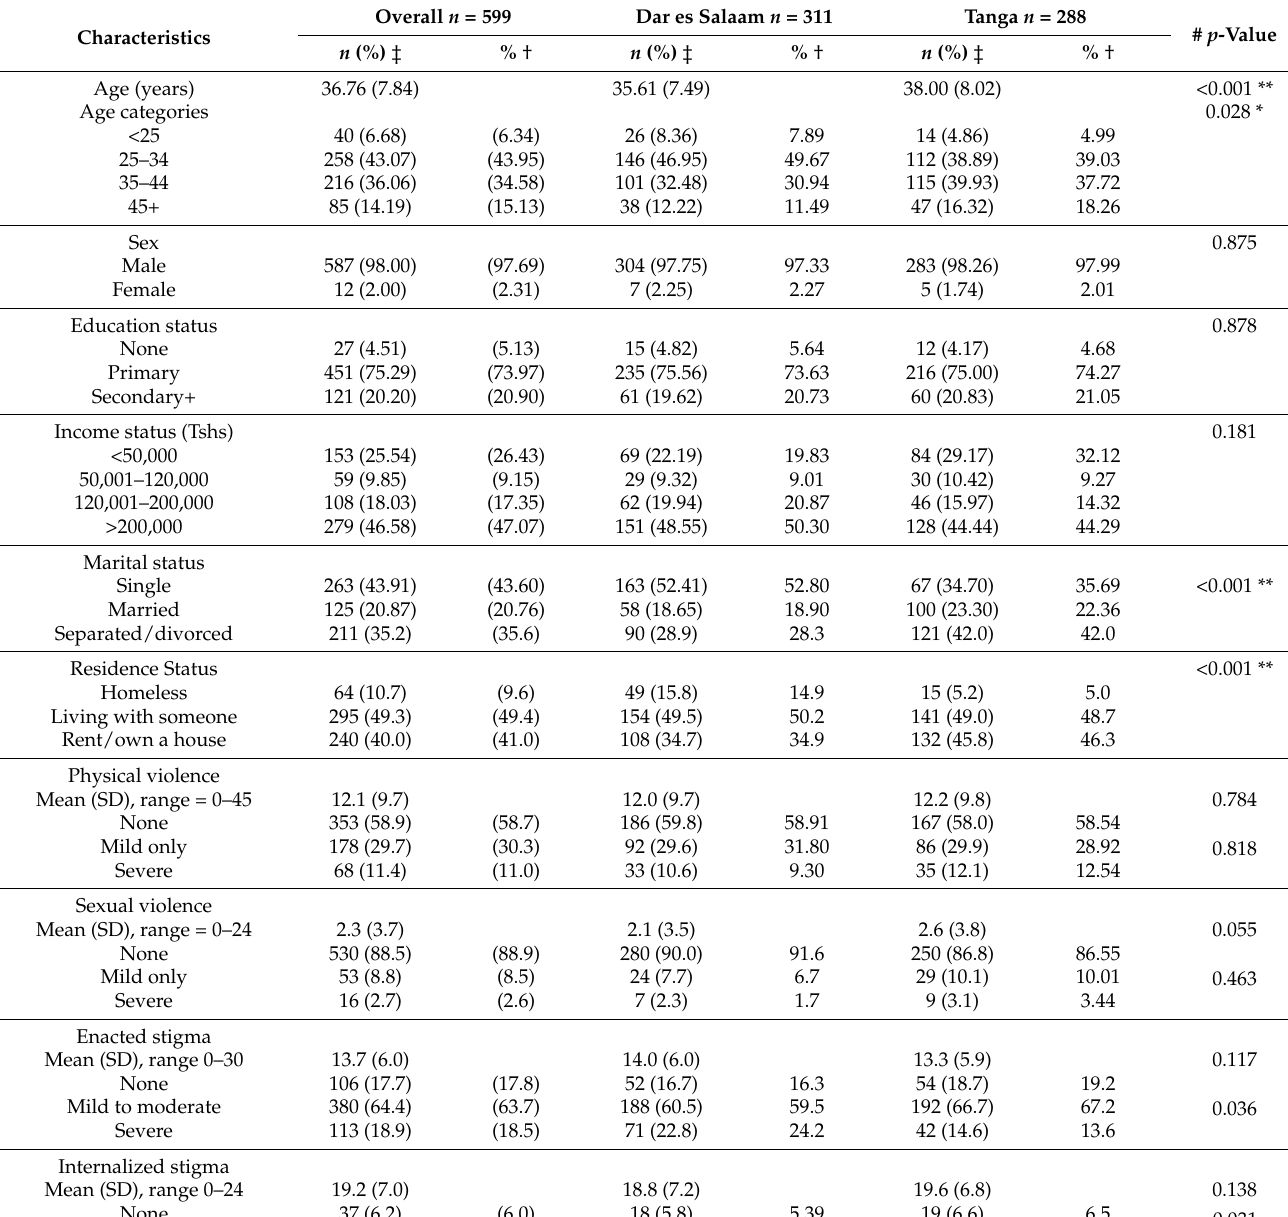
Table 1. Demographic, social, and structural characteristics of the study participants in Dar es Salaam and Tanga ( n =